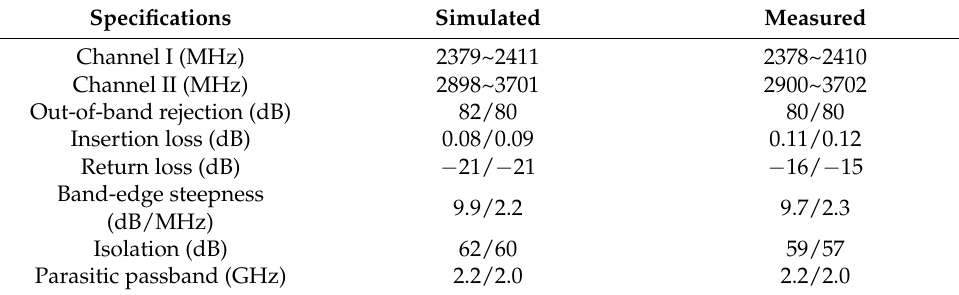
Table 4. Simulated and measured response of the